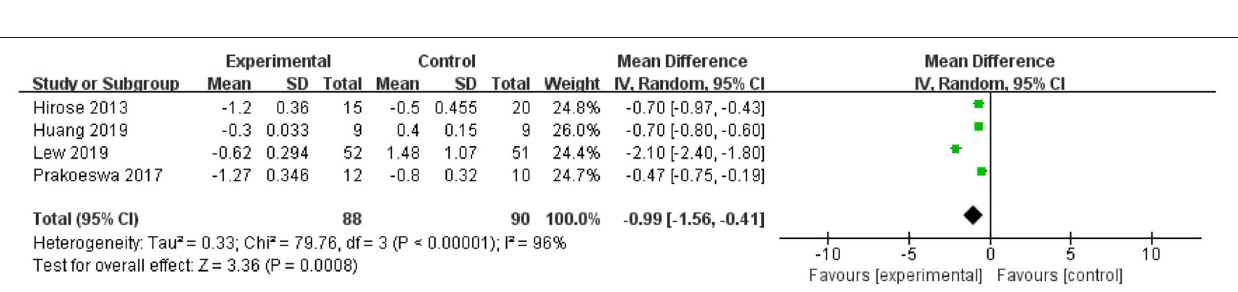
FIGURE 5 | Forest plot of effect of Lactobacillus plantarum on IFN- γ . SD, standard deviation; Total, sample size of each group; Mean Difference, the mean value of the experimental group minus that of the control; 95% CI, 95% confidence intervals. Klebsiella pneumonia (36). As an anti-inflammatory factor, IL-10 is vital in protecting the host from tissue damage during